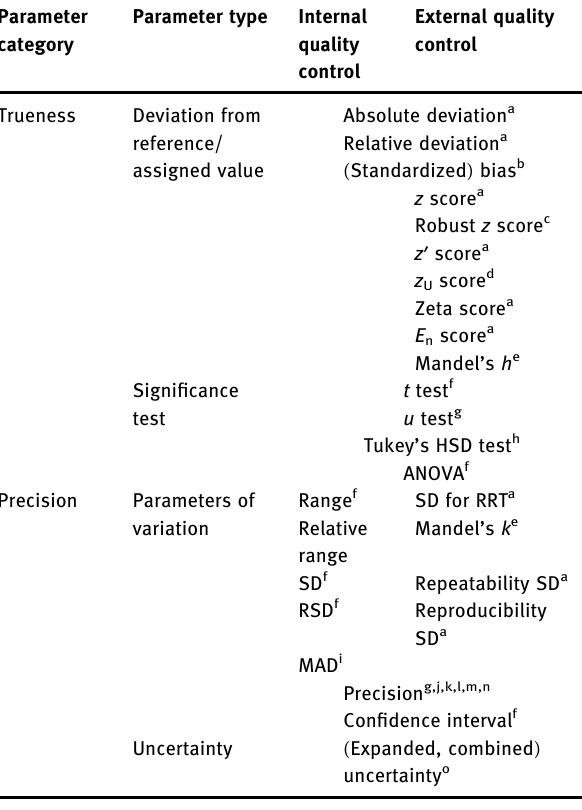
Table 2: Categorization of